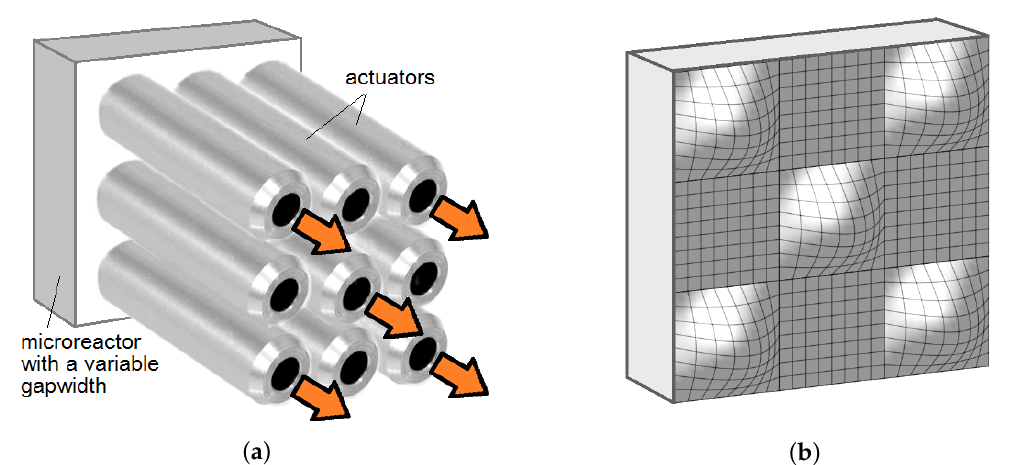
Figure 1. ( a ) Schematic representation of the method for controlling the local gapwidth of a Hele-show cell using a system of actuators; ( b ) Deformation of the cell wall, which corresponds to the configuration of the operating actuators shown in ( a